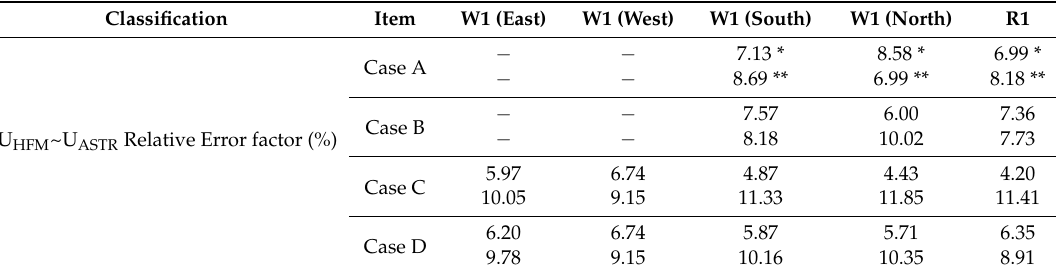
Table 7. Measured relative error rate results of U HFM and U ASTR